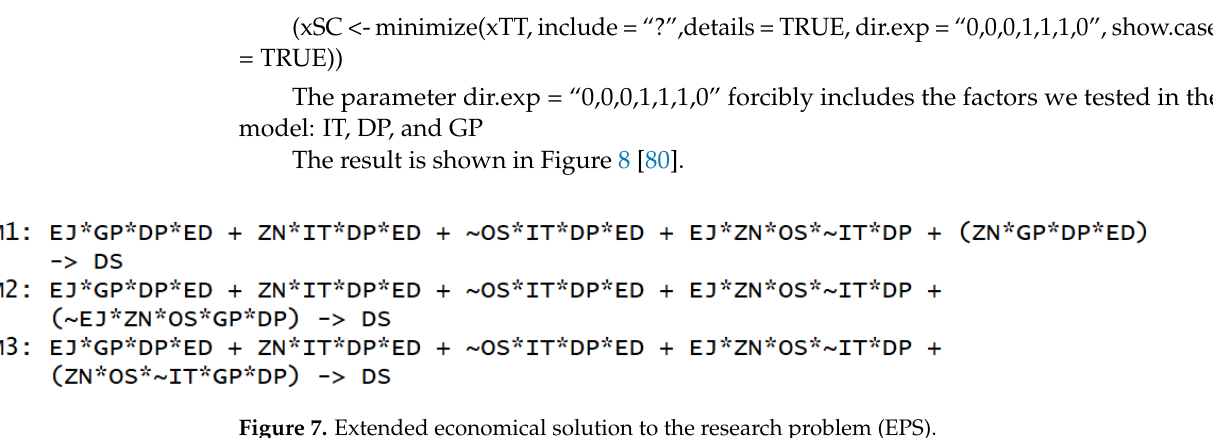
Figure 7. Extended economical solution to the research problem (EPS).